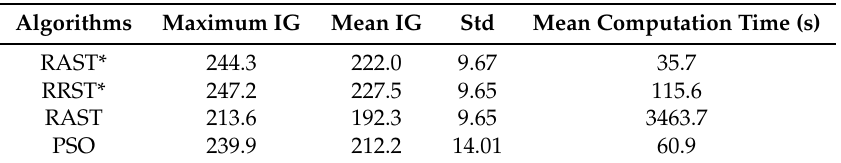
Table 1. Performance comparison of rapidly-exploring adaptive sampling tree star (RAST*), rapidly- exploring random sampling tree star (RRST*), rapidly-exploring adaptive sampling tree (RAST), and particle swarm optimization (PSO) for Scenario 1.